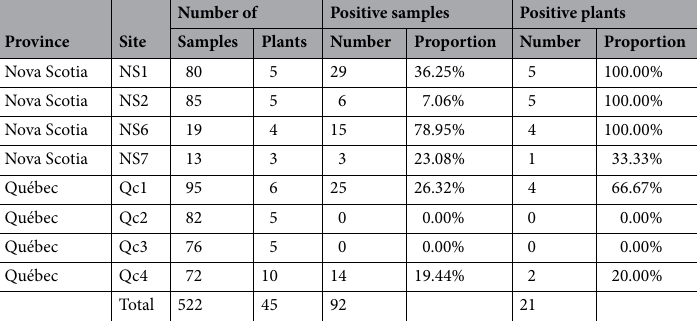
Table 4. Summary of BBSP LAMP assay results on field samples taken in 2016.